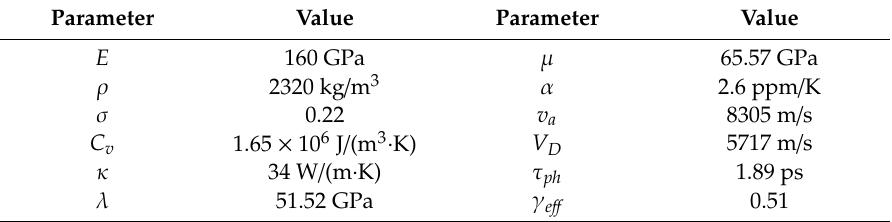
Table 1. The measured Q values of the 37 and 18 µ m-radius resonators vibrating in the atmosphere.